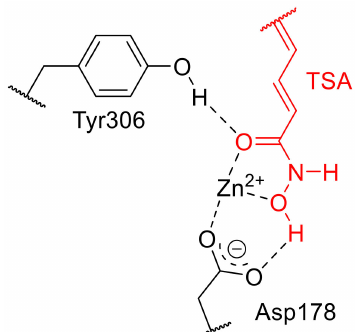
Figure 5. Interactions of TSA in the co-crystallized structure with the human HDAC8 (PDB ID: 1T64) and chelation with Zn 2+ .